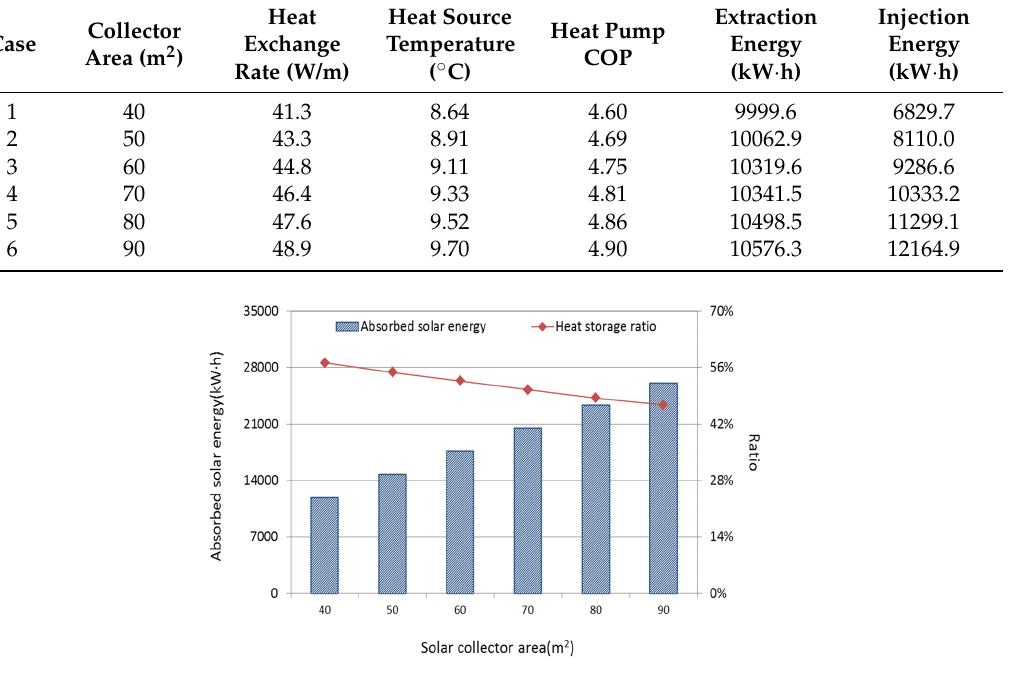
Table 3. Simulation results with different collector area.